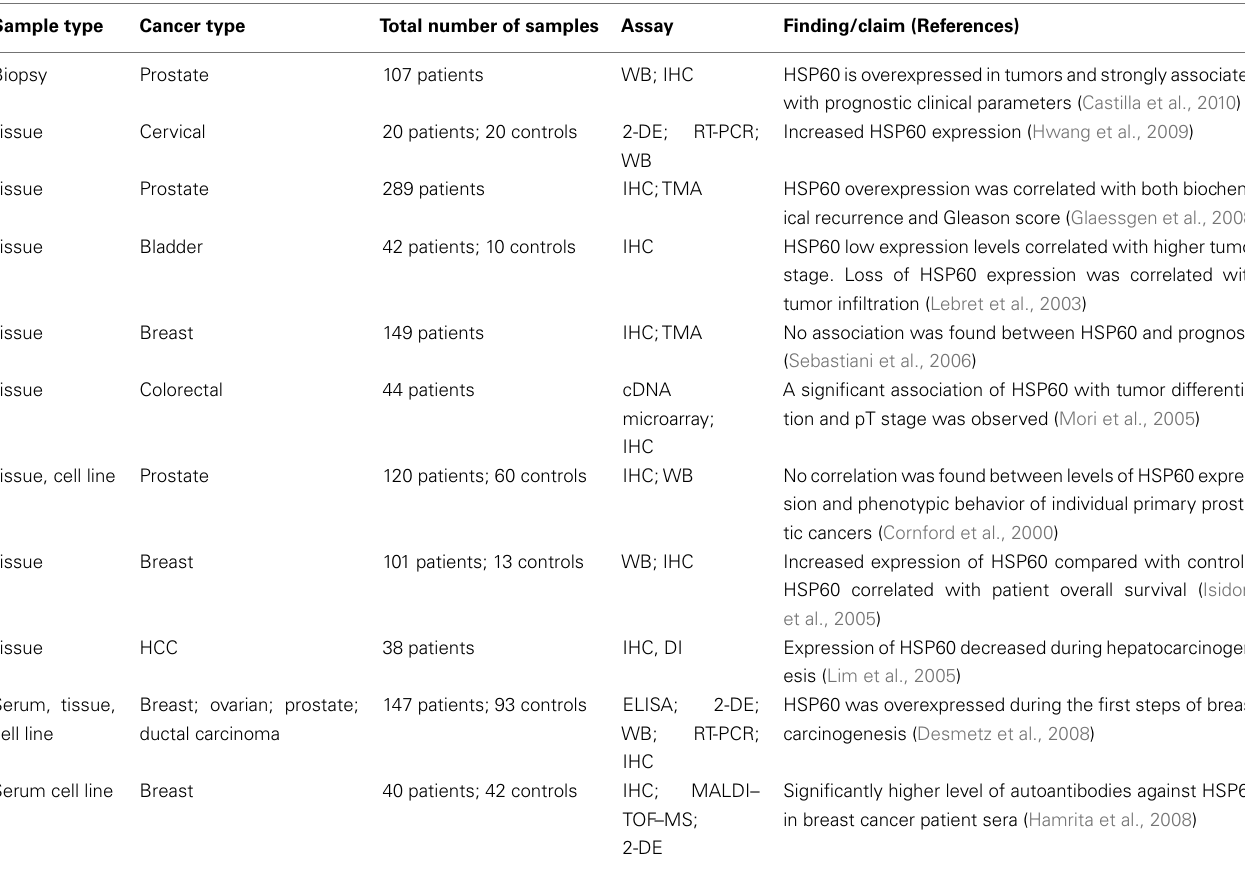
Table 2 | Selection of recent publications assessing HSP60 as a biomarker in